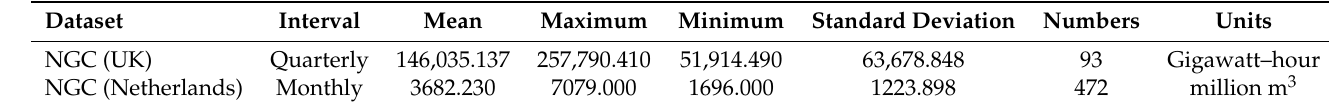
Table 4. Statistical features of the dataset.